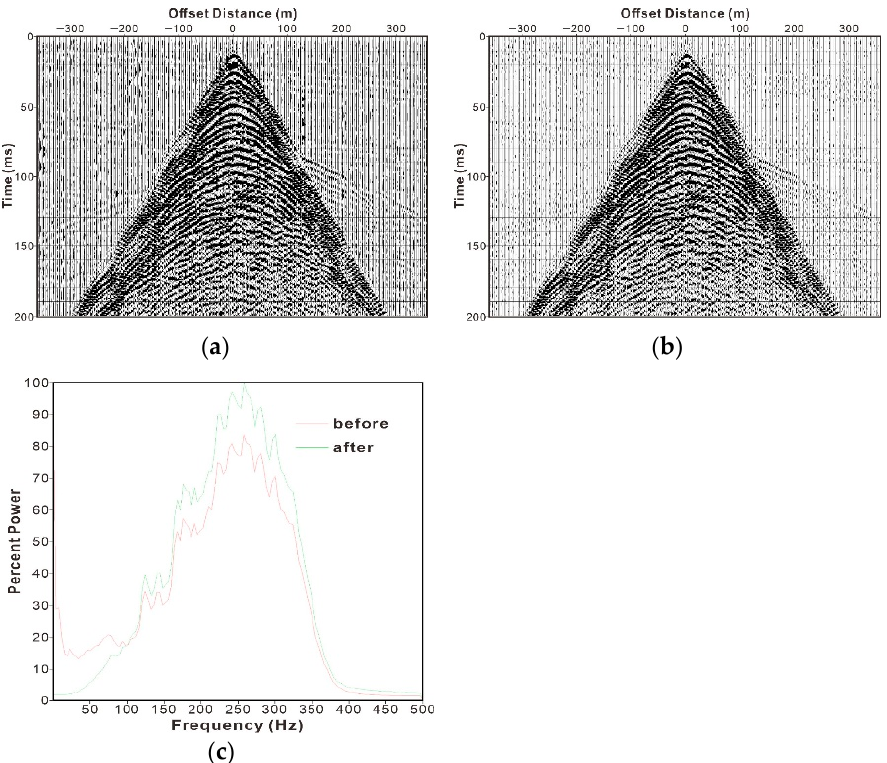
Figure 5. Seismic data recorded by the unmanned wave glider ( a ) before and ( b ) after filter application, and ( c ) amplitude spectra of ( a ) and ( b ). Table 3. Filters applied to noise reduction.